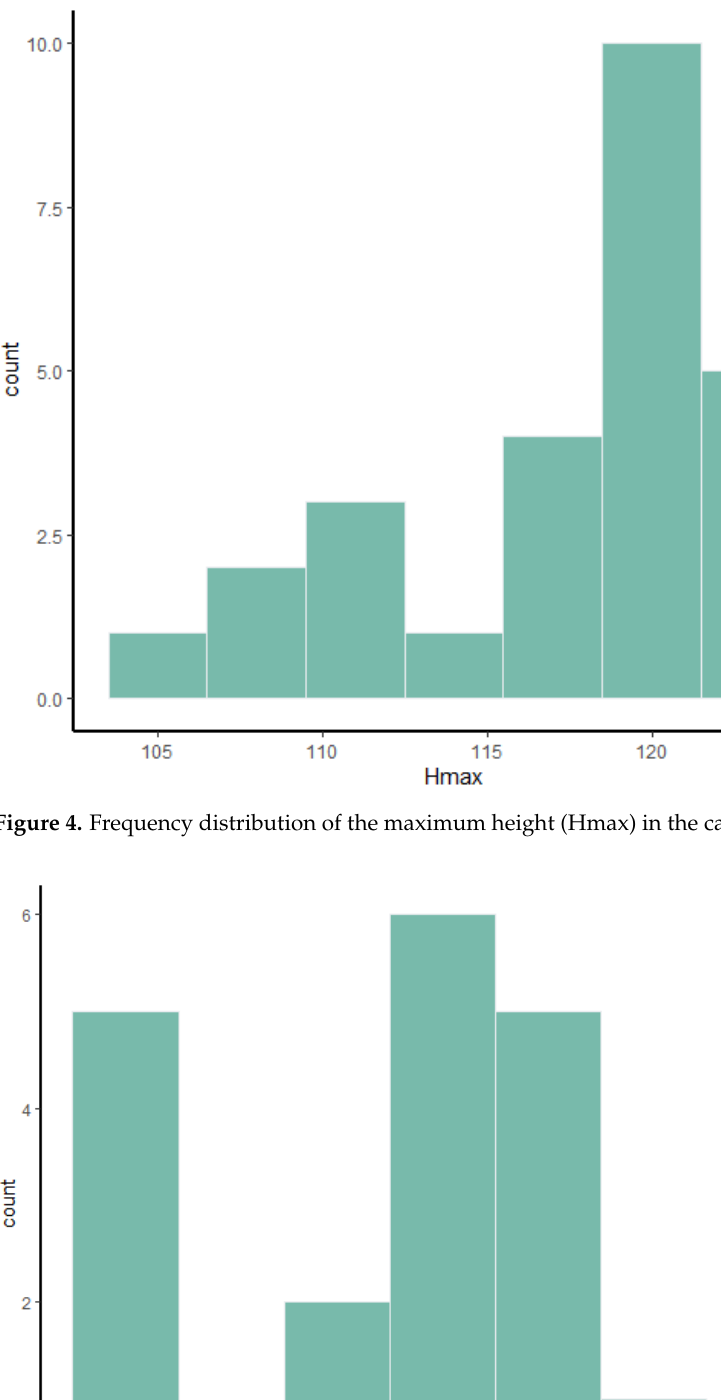
Figure 3. ( a ) Frequency distribution of the height of the trochlea’s medial lip (HTm) and ( b ) the maximum transverse diameter in the astragalus of S. etruscus.